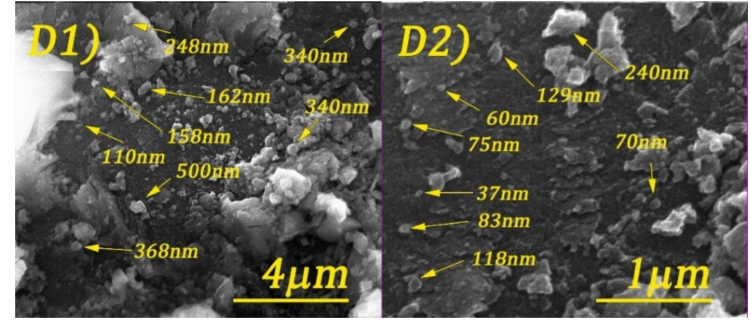
Figure 8. SEM images of CoFe 2 O 4 -0.5 at different magnifications: 20 kX ( D1 ) and 80 kX ( D2